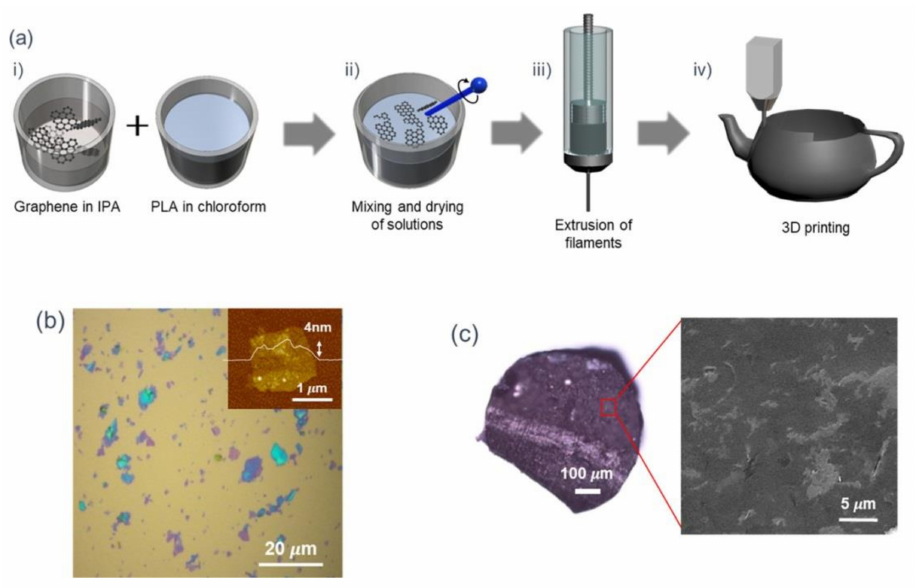
Figure 11. ( a ) Schematic process flow of the GNP − PLA composite fabrication, extrusion, and 3D printing: (i) GNP dispersion in IPA and dissolution of PLA in chloroform, (ii) mixing and drying of two dispersions, (iii) extrusion of the GNP − PLA filaments, and (iv) 3D printing of the GNP − PLA object. ( b ) Optical micrograph of graphene flakes spray-coated on a SiO 2 substrate. AFM image of a representative graphene flake in the inset, with a height profile to measure the flake thickness. ( c ) Optical image and magnified SEM image of the cross-section of the GNP − PLA filament (Reproduced with permission from Reference [126], copyright 2019, American Chemical